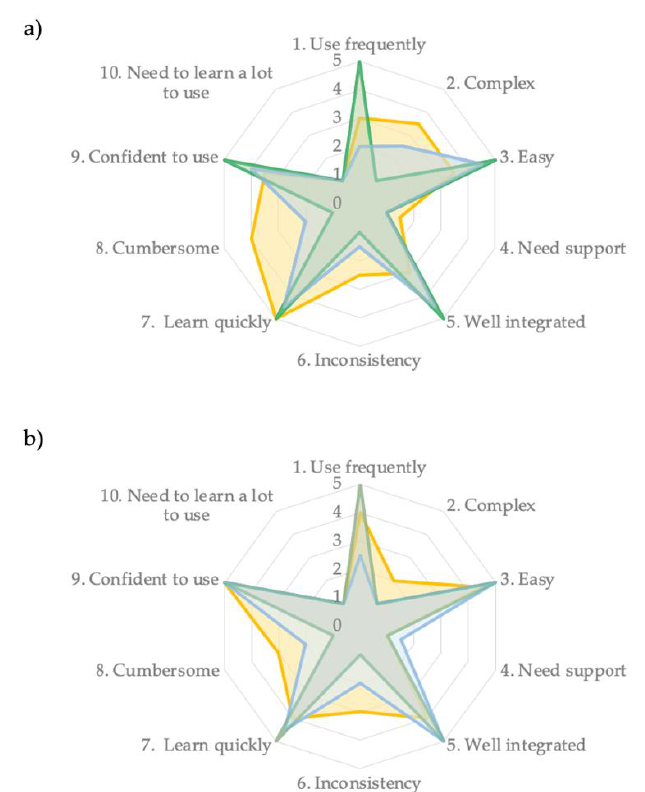
Figure 4. Usability findings of the Angles app ( a ) and DrGoniometer app ( b ) evaluated with the system usability scale (SUS) by experienced and inexperienced raters, respectively, in yellow and blue. The mean score collected by experienced and inexperienced raters, respectively, in yellow and blue, was reported for the ten SUS items (1: totally disagree; 5: totally agree). The green stars indicated the best possible usability results.